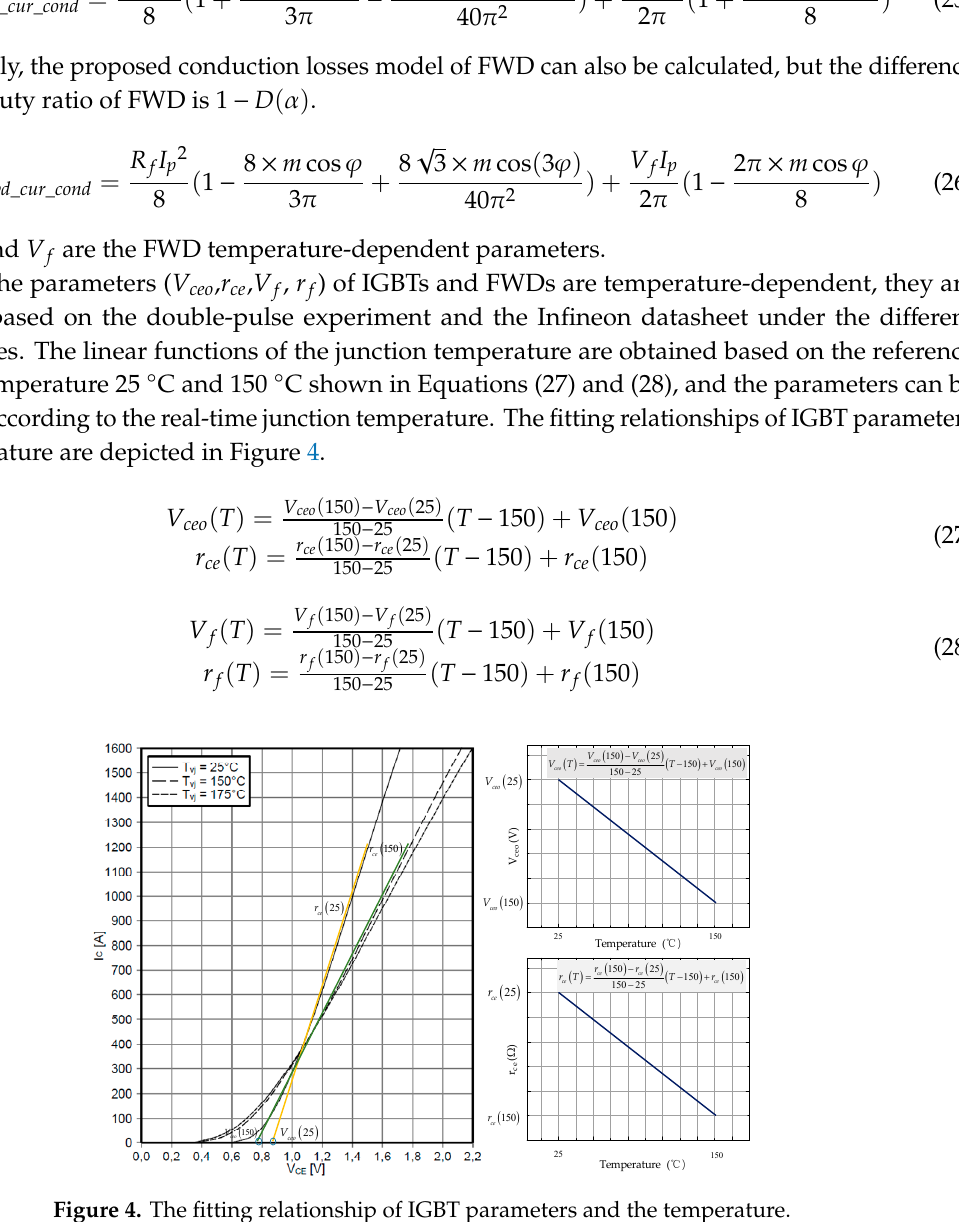
Figure 4. The fitting relationship of IGBT parameters and the temperature.